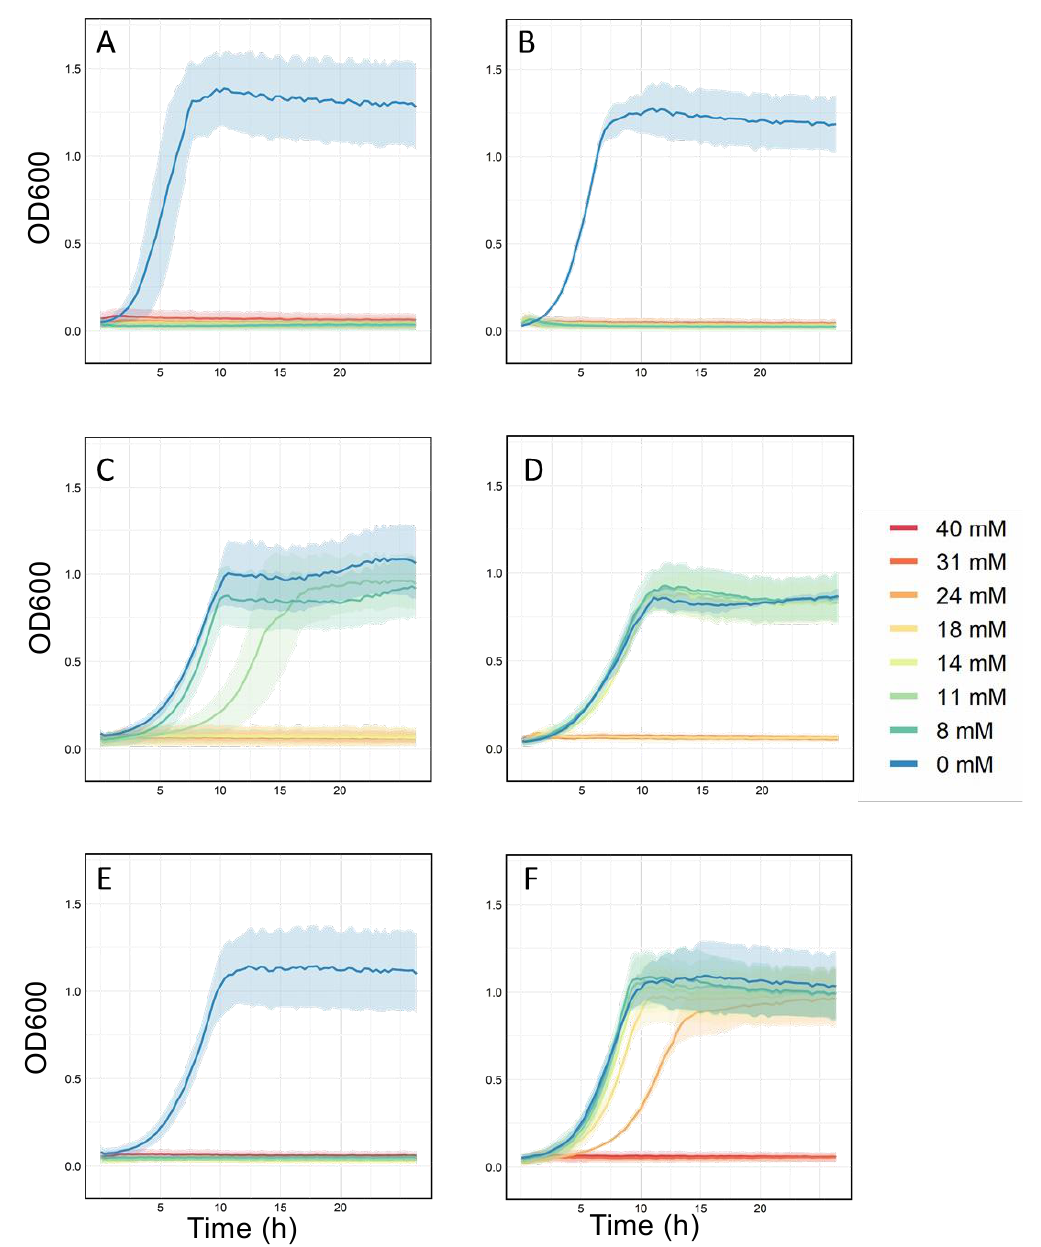
Figure 2. Phenotypic characterization of the evolved strains. Depicted is the growth curves of representative clones derived from eTRef and eMRef populations in comparison to their ancestral strain Ref . The phenotypic assessment was performed in the indicated concentration gradient of TPP + and MTPP + . ( A ) Growth of ‘ Ref ’ strain in TPP + . ( B ) Growth of ‘ Ref ’ strain in MTPP + . ( C ) Growth of eTRef evolved strain in TPP + . ( D ) Growth of eTRef evolved strain in MTPP + . ( E ) Growth of eMRef evolved strain in TPP + . ( F ) Growth of eMRef evolved strain in MTPP + . Shaded area represents standard deviation ( n = 4).